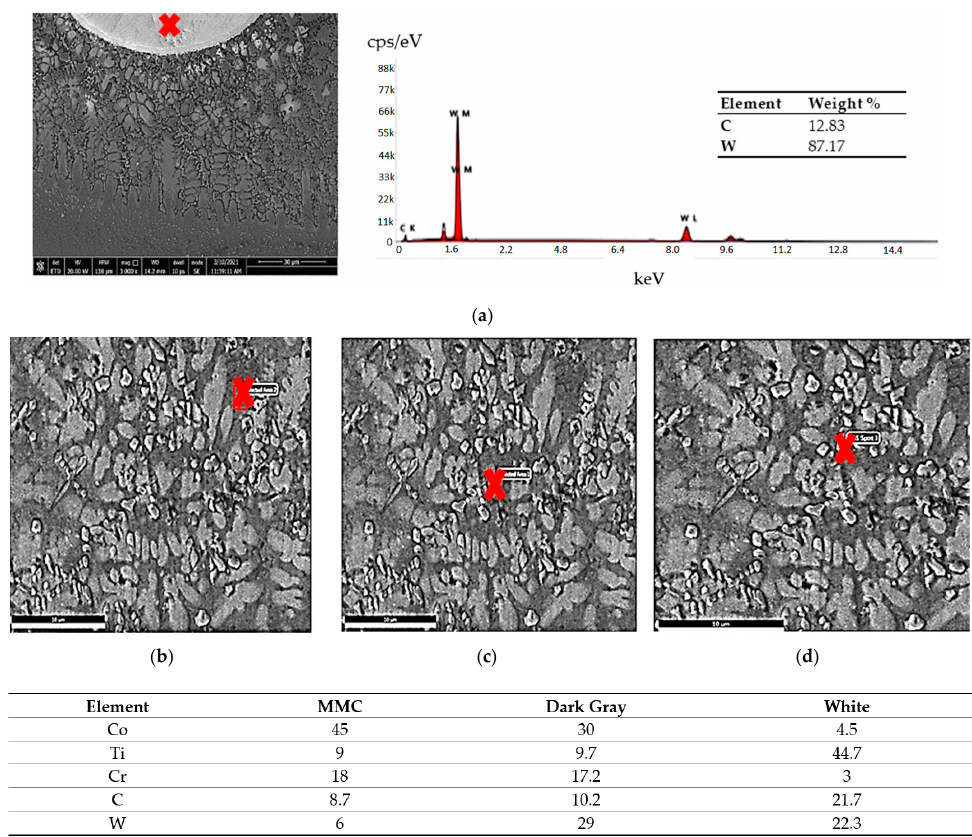
Figure 11. EDAX point analysis results of the deposited layer made with 60% stellite-6 powder + 40% WC: ( a ) WC particles, ( b ) (MMC) gray, ( c ) dark gray, ( d ) white, and ( e ) the chemical analysis of each constituent. The deposition zone shows different particle sizes of undissolved WC particles (bright white or silver; Figure 11a); furthermore, two different cluster types were identi- fied based on the color difference inside the MMC. The MMC was characterized by a gray color that mainly comprised stellite-6 powder elements, whereas the dark gray clusters contained a Co-based alloy with 29% WC and the white color included a high percentage of Ti element in addition to W and C elements, as listed in Figure 11d. The distribution of all elements along the deposited layer is presented in the EDAX line scan shown in Figure 12. Such results confirmed that Co, Cr, Ti, W, and C elements in the deposited layer were uniformly distributed along the MMC depth. Higher W and C percentages were detected due to the addition of 40% WC to the deposited powder. The peaks of the Co, Cr, and W elements increased upon passing over the matrix, whereas the peaks of the Ti element decreased.